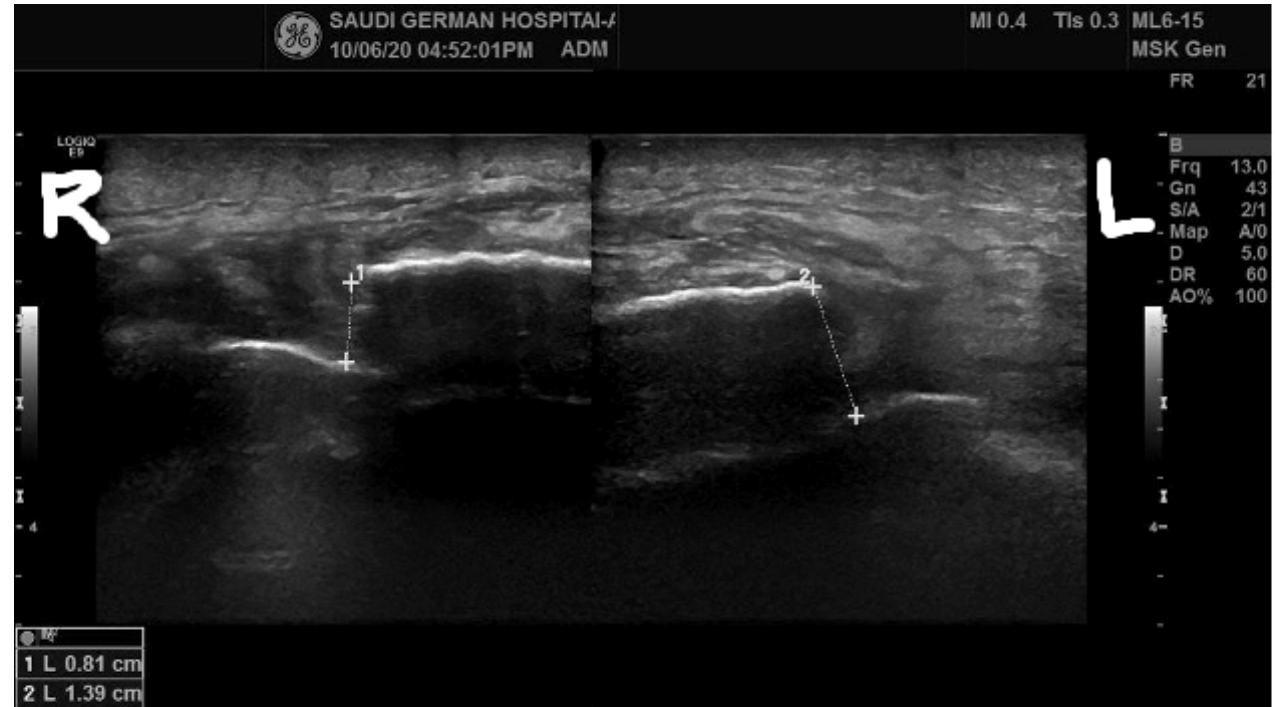
Figure 4. The patient’s standing bilateral knee X-ray did not reveal any periprosthetic fracture.